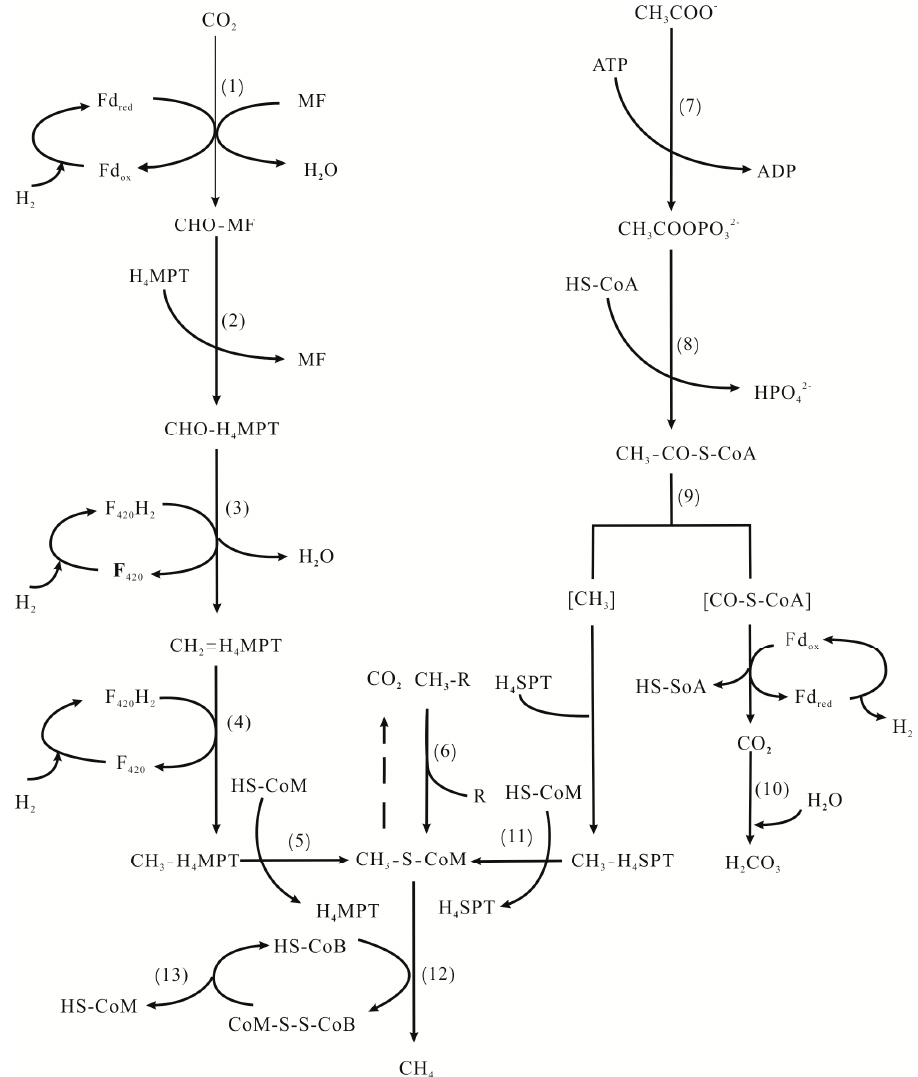
Figure 6. Biochemical pathways of methanogenesis [87].